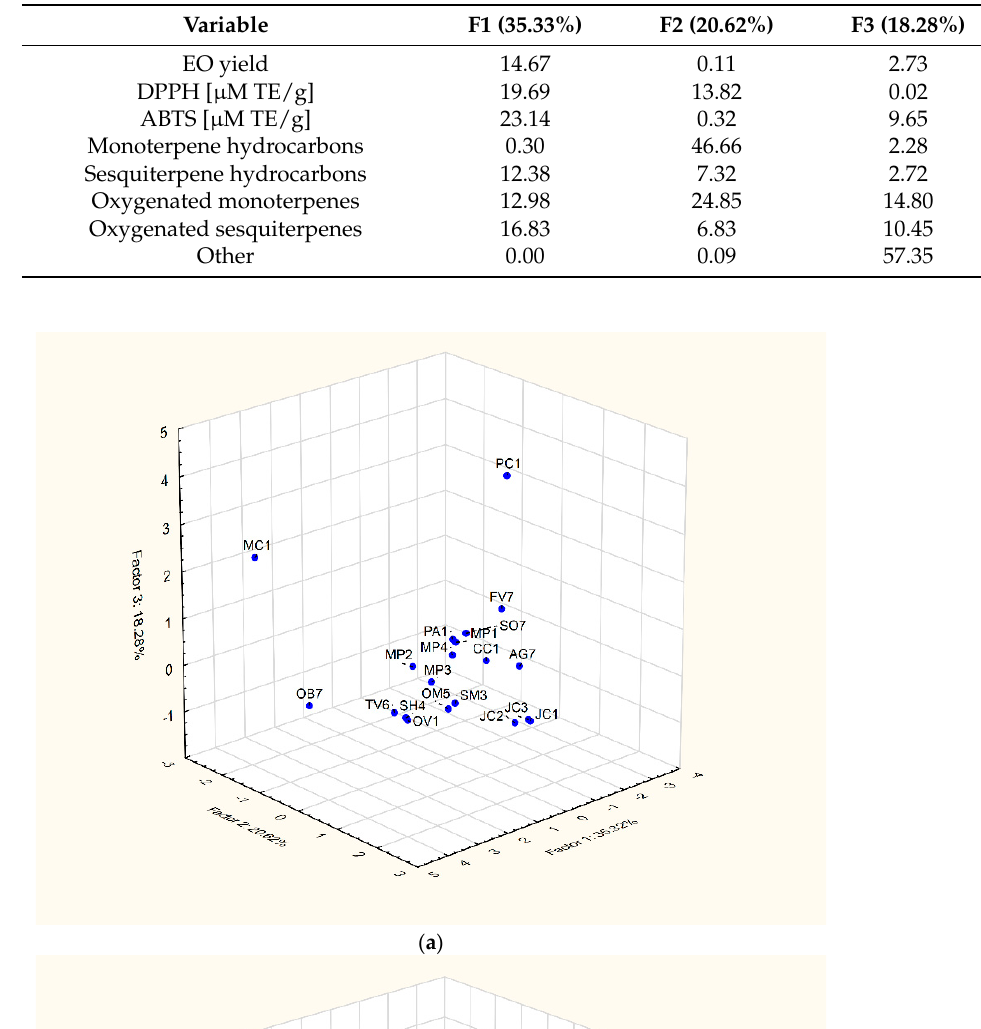
Table 7. Contribution of corresponding variables (%) to the first three principal components.